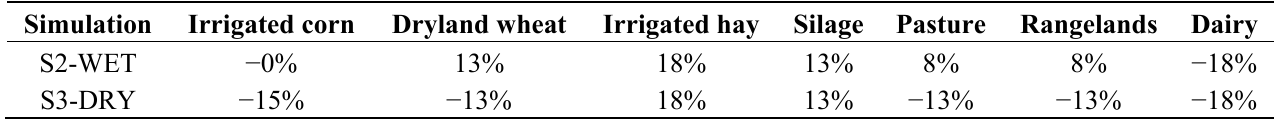
Table 2. Percent yield and productivity changes in S2-WET and S3-DRY, relative to S1. Sources: [13] (pp. 34–48, 56–61, 77–82).